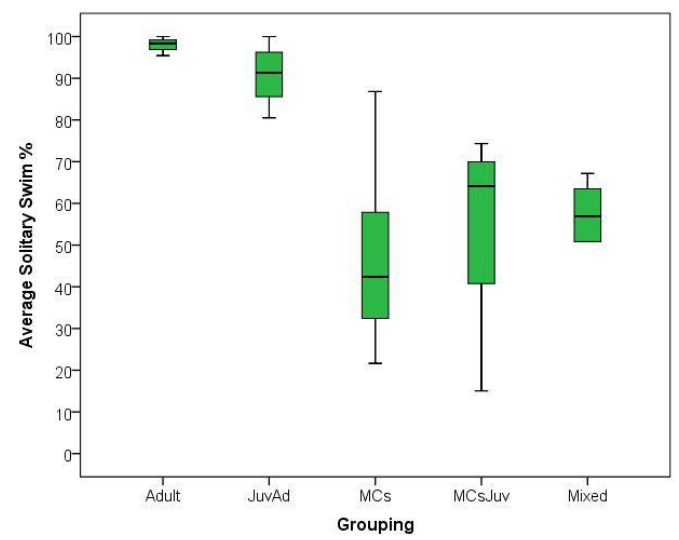
Figure 1. Boxplots of average solitary swim percentage per social grouping. Note the scale is a 100%.